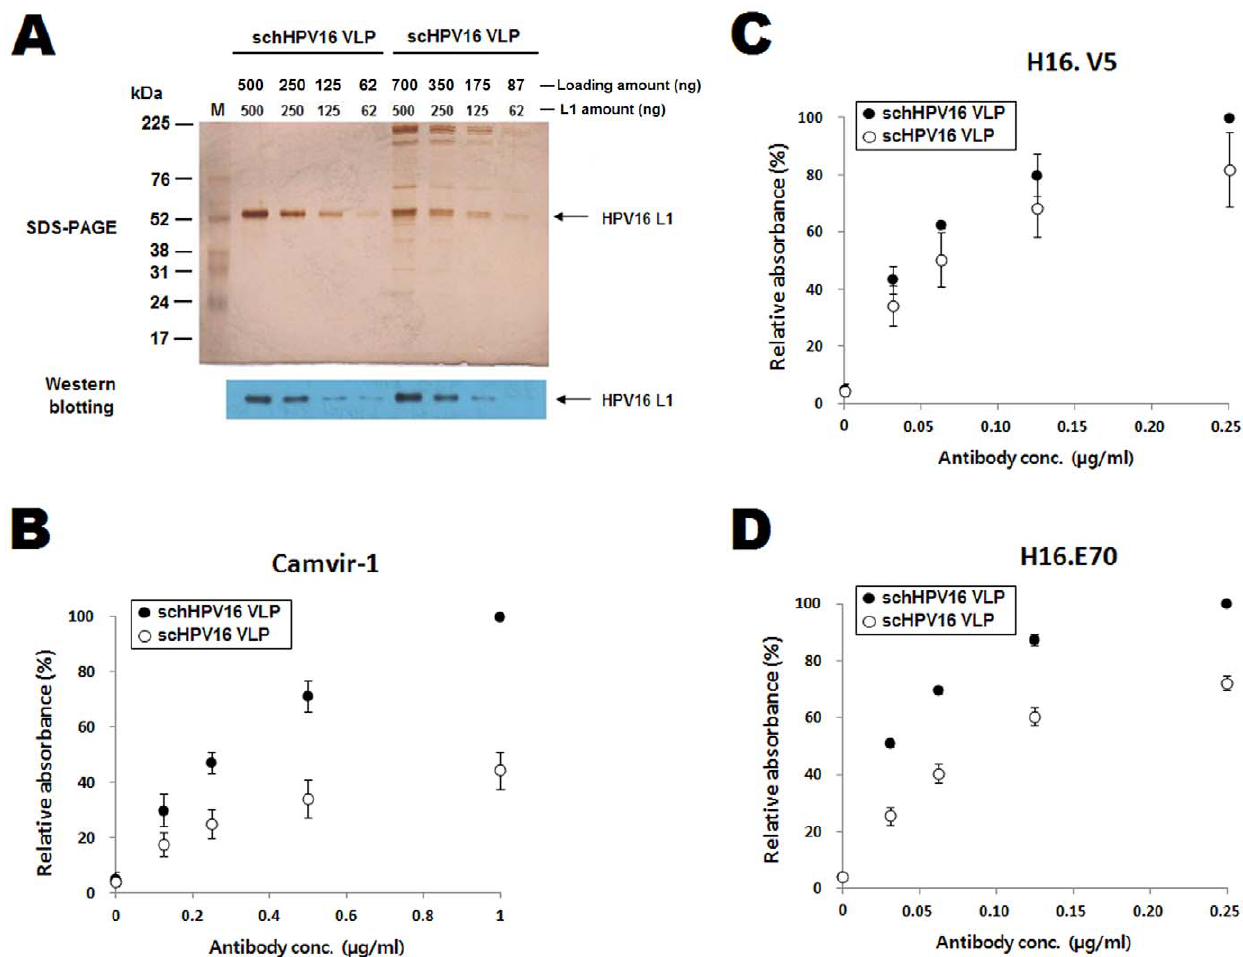
Figure 2. Camvir-1, H16.V5 and H16.E70 reactivity towards scHPV16 VLPs and schHPV16 VLPs. The amounts of L1 proteins contained in scHPV16 VLP and schHPV16 VLP were confirmed by SDS-PAGE and Western blotting prior to performing ELISAs (A). In panel A, loading amount indicates protein amount loaded for SDS-PAGE and Western blot. L1 amount indicates L1 protein amount contained in the loading sample. The L1 protein amount was confirmed by L1 band intensities on SDS-PAGE and Western blot. M indicates the molecular weight marker. The SDS-PAGE and western blot are representatives of duplicate assays. The Camvir-1, H16.V5 and H16.E70 reactivity towards schHPV16 VLPs and scHPV16 VLPs were determined by direct ELISA and are presented in B, C and D, respectively. The ODs of hHPV16 VLPs after reaction with 1 m g/ml of Camvir-1, 0.25 m g/ ml of H16.V5 and 0.25 m g/ml of H16.E70 were set at 100% in B, C and D, respectively. The ELISA values are the means 6 SD of two independent (Table 1). The L1 protein concentrations of the two VLP